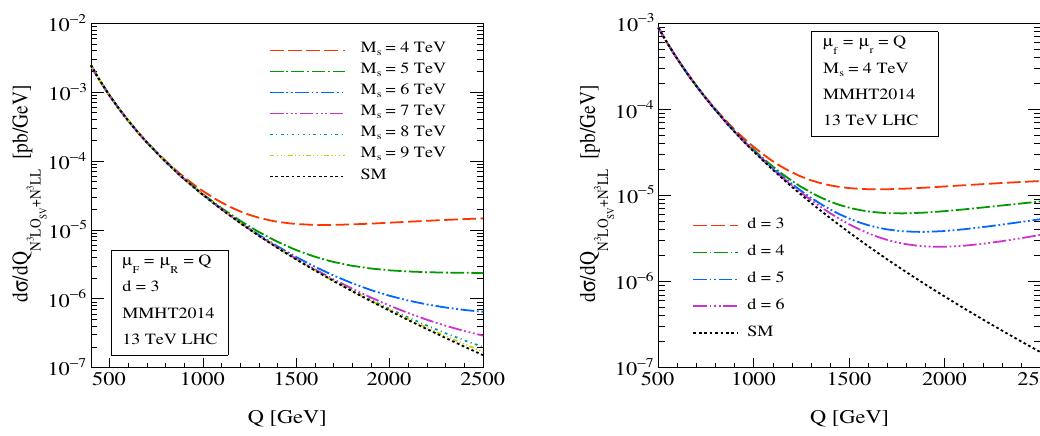
Figure 11 . E(cid:11)ect of model parameters for invariant mass distribution of di-lepton at hadronic center of mass energy 13 TeV for signal at N 3 LO sv +N 3 LL level. Left panel for M S variation for d = 3 and right panel for d variation for M S =